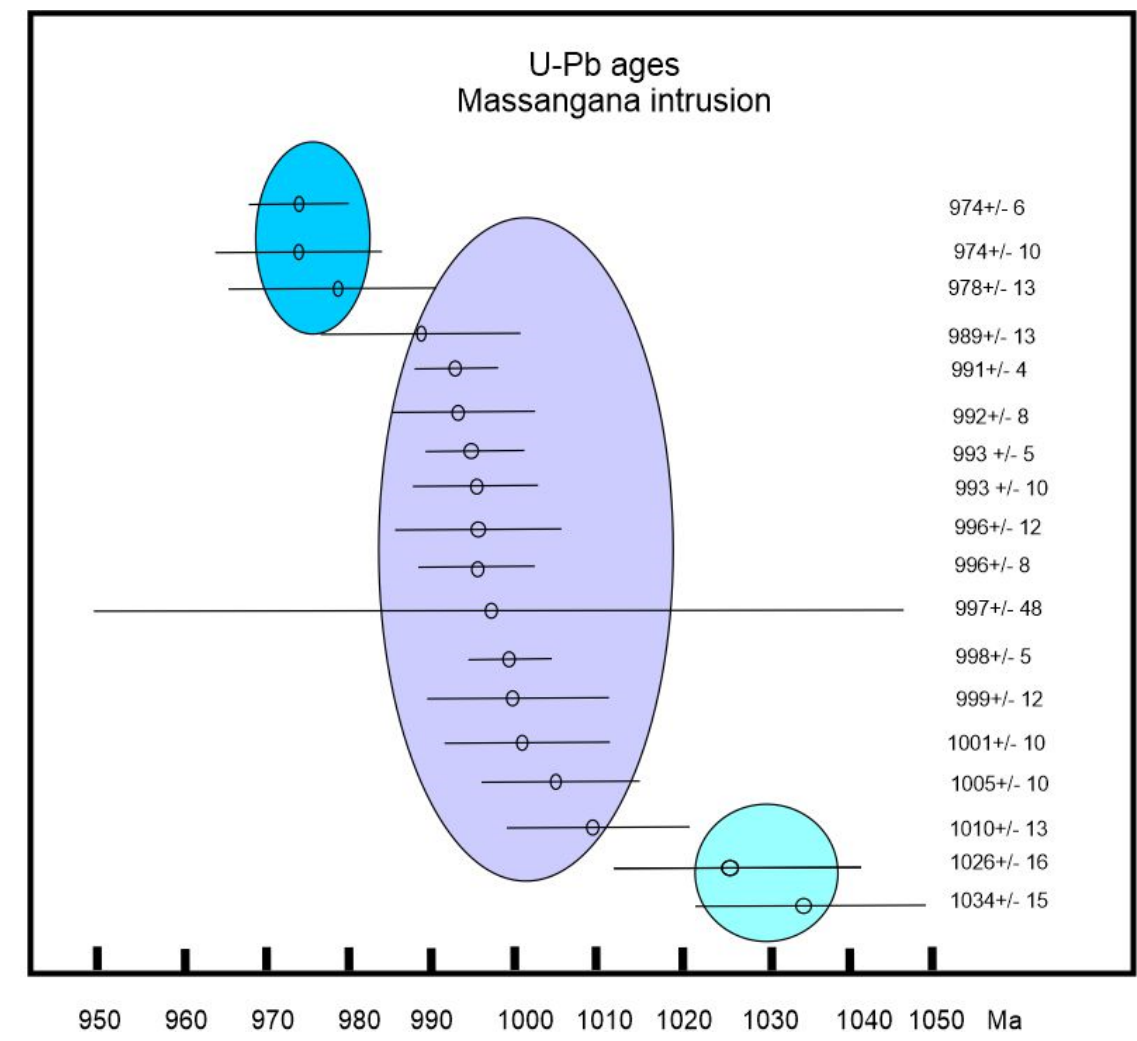
Figure 20. U − Pb ages of the Massangana Massif samples. Distribution diagram of the U − Pb ages in zircon, except for one monazite (997 ± 48 Ma) from the granites of the Rondônia Tin Province. Source: [19,57].